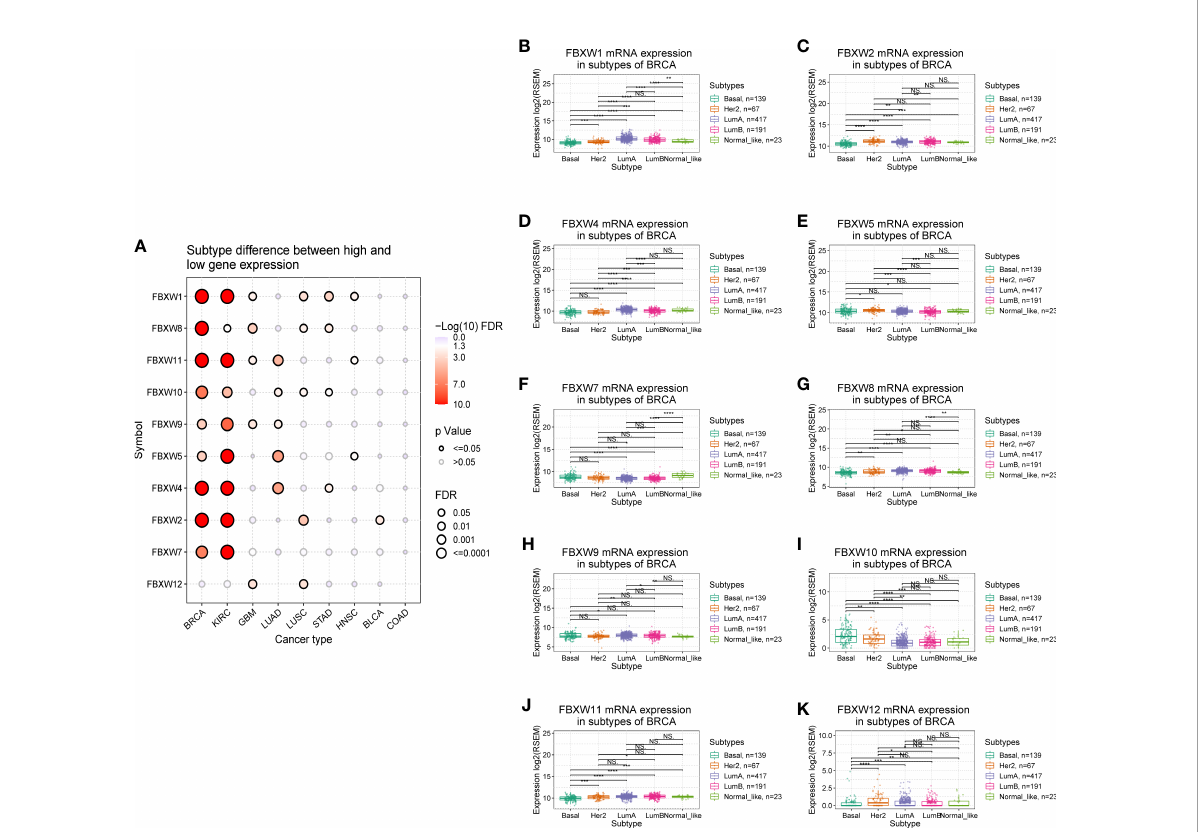
FIGURE 5 Correlation analysis between FBXW family gene expression and the subtypes of various tumors. (A) Subtype differences between high and low gene expression of FBXWs. (B – K) the relationship between FBXWs expression and the subtype of BRCA. ∗ P< 0.05, ∗∗ P< 0.01, ∗∗∗ P< 0.001 and